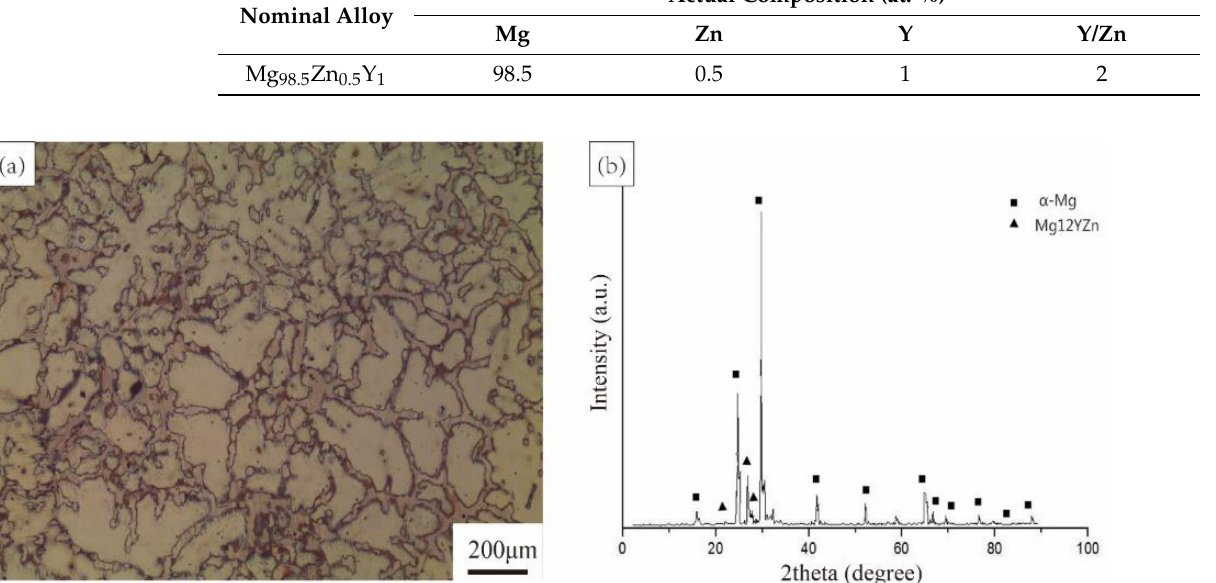
Table 1. Chemical composition of the Mg 98.5 Zn 0.5 Y 1 alloy. Nominal Alloy